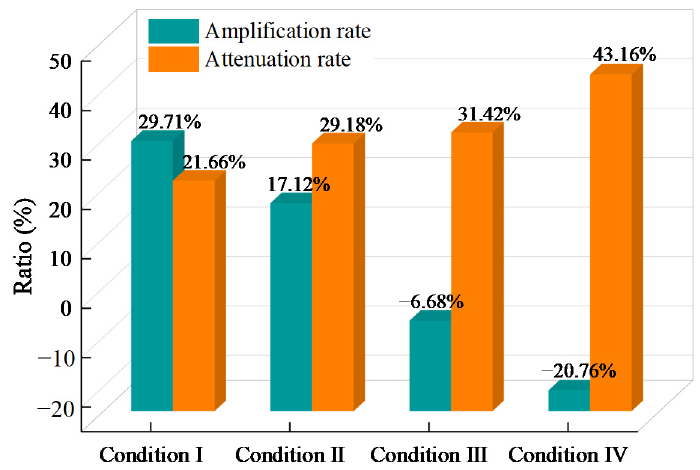
Figure 10. Comparison of amplification rate and attenuation rate.